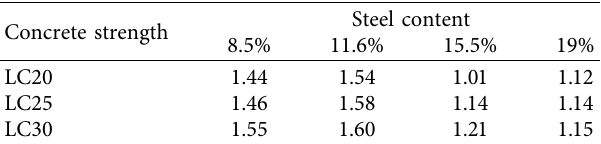
Table 5: Ductility factor with various percentages of steel content of